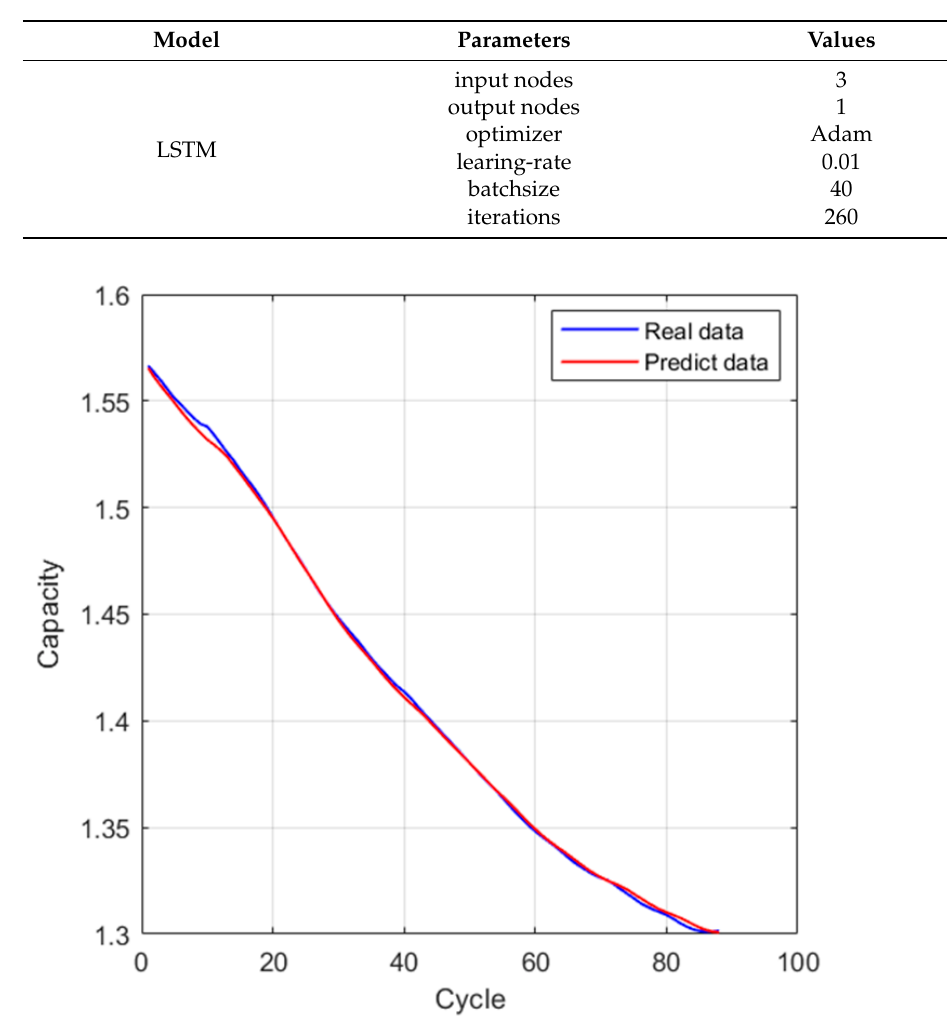
Figure 5. Prediction results of residual components of B0005 battery.